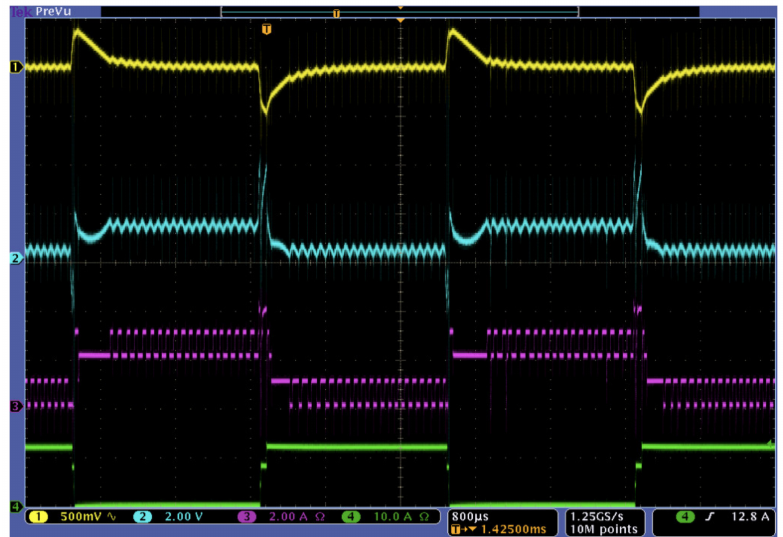
Figure 11. Experimental results (large load perturbation), ILoad = 2.5–12.5 A. Yellow, bus voltage ripple; blue, low-power sections control signal; pink, low-power sections bus current; green, high- power sections bus